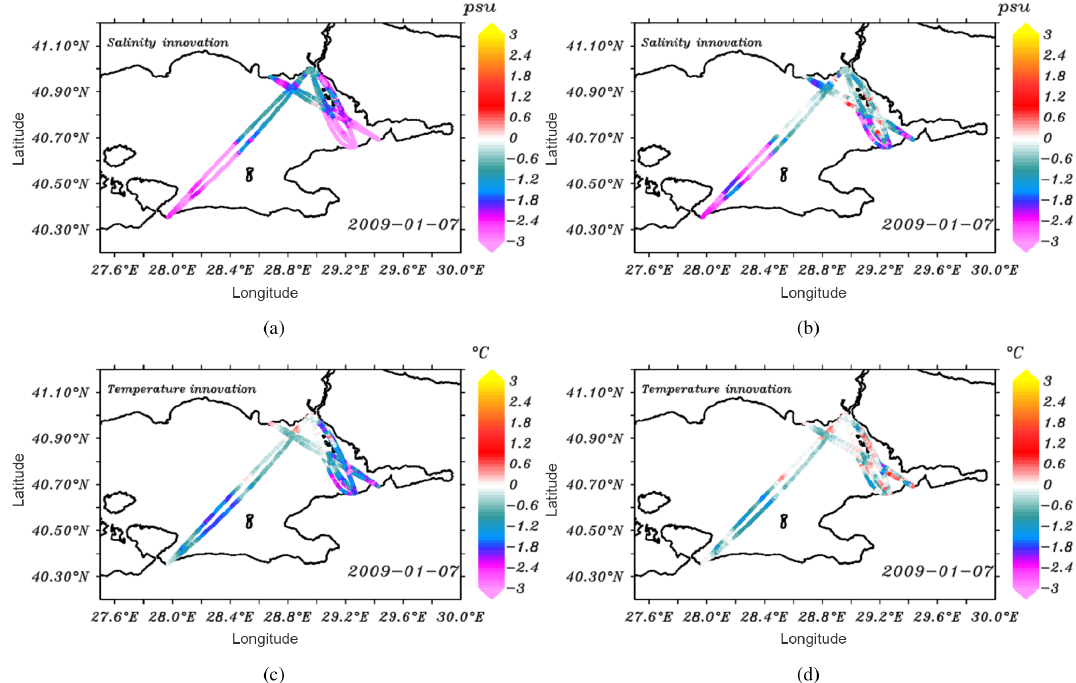
Figure 9. Horizontal distribution of salinity (a, b) and temperature (c, d) innovations along the ferry tracks on 7 January 2009 for FB001 (a, c) and FB002 (b, d) . Observations with an innovation out of the range ± 3 are considered as outliers.